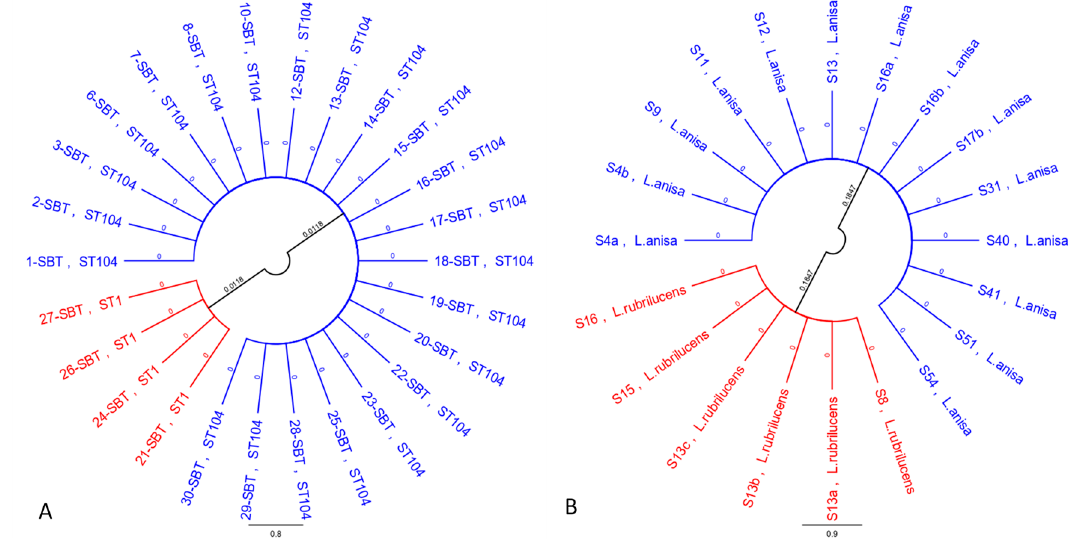
Figure 1. Phylogenetic trees of L. pneumophila ( A ) and non- pneumophila Legionella species ( B ) strains.